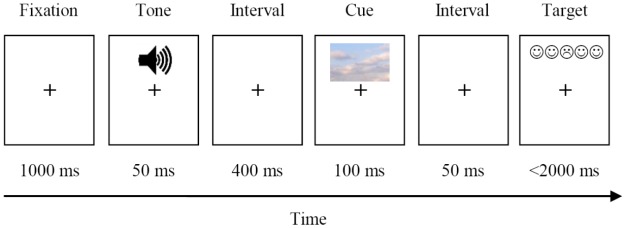
Experimental procedure of E-ANTI.